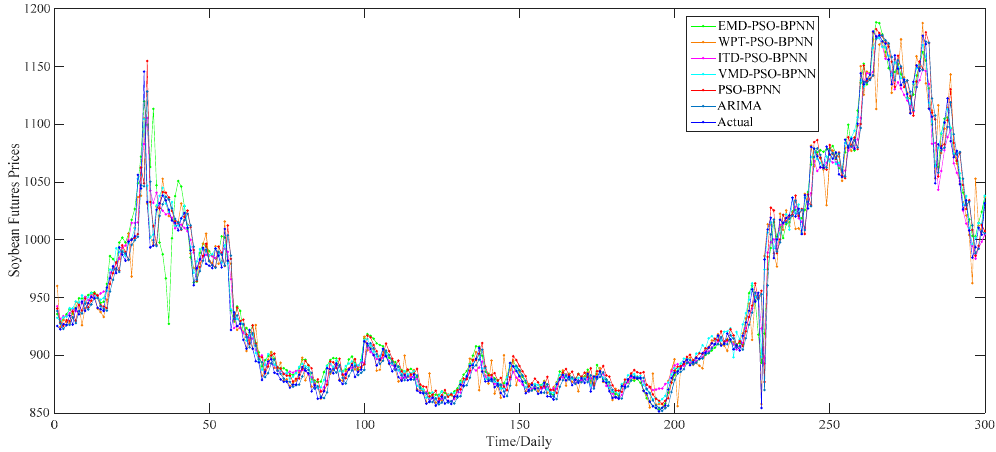
Figure 23. One-day-ahead forecasting results of different models of soybean.